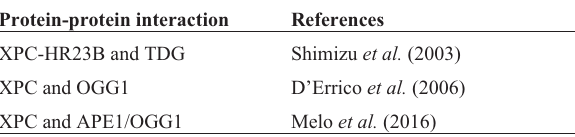
Table 2 - Protein interactions between BER and